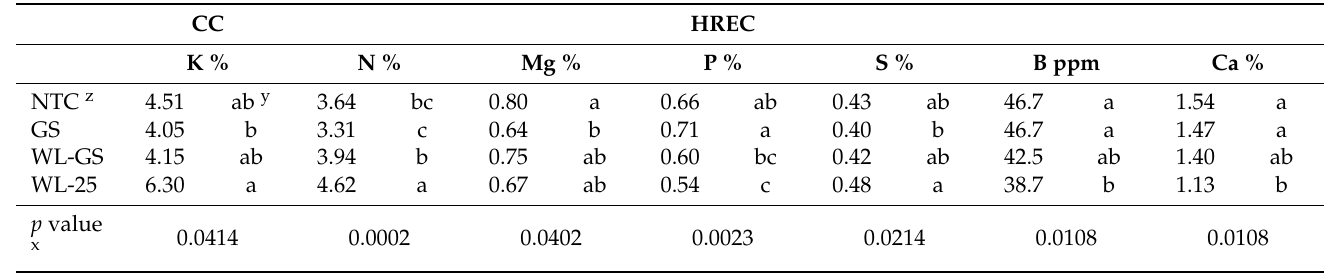
Table 6. Mean comparison by fertility treatment of differences in mineral nutrient content of spinach leaf tissues collected at harvest, where initial ANOVA for all treatments was significant at α =